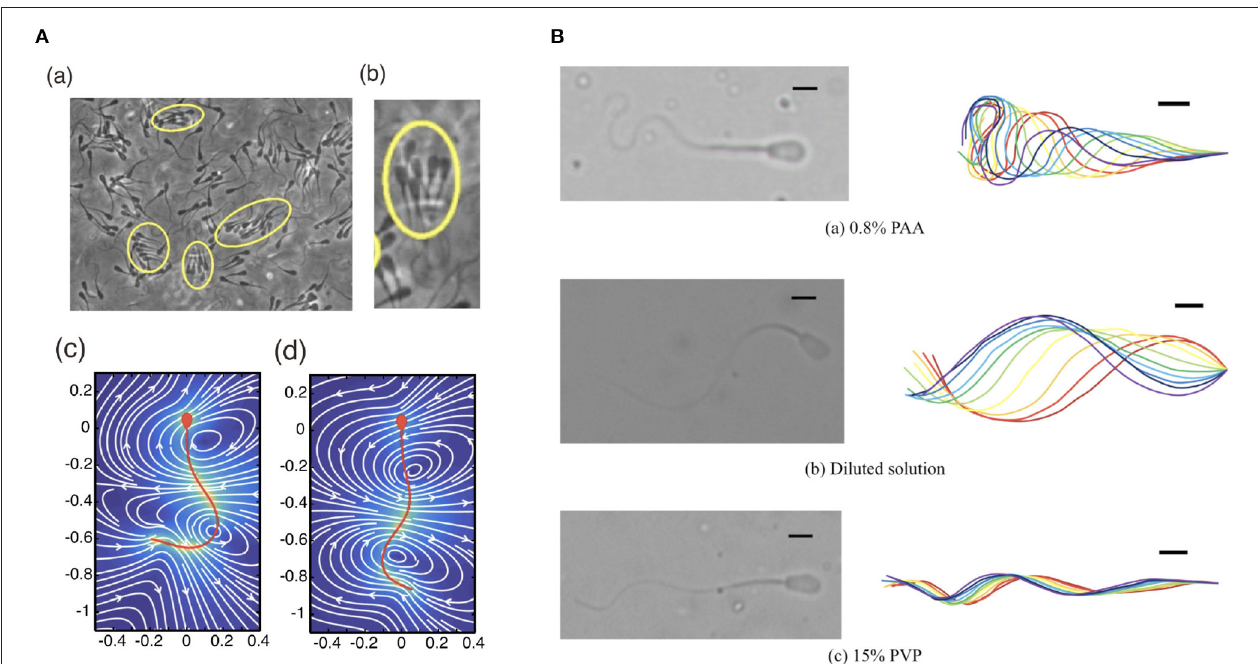
FIGURE 4 | Different waveforms in different environments. (A) (a,b) Bull sperm cluster in a viscoelastic medium (Tung et al., 2017) and the flow of (c) low and (d) high viscous medium around human sperm cells (Ishimoto and Gaffney, 2018b). (B) Different waveforms seen in bull sperm cells in different rheological media (Hyakutake et al., 2019) (A) (a,b) republished from the works of Tung et al. (2017) and (A) (c,d) republished from the works of Ishimoto and Gaffney (2018b), all with permission under the terms of the Creative Commons Attribution License http://creativecommons.org/licenses/by/4.0/. (B) reprinted from Hyakutake et al. (2019) with permission from